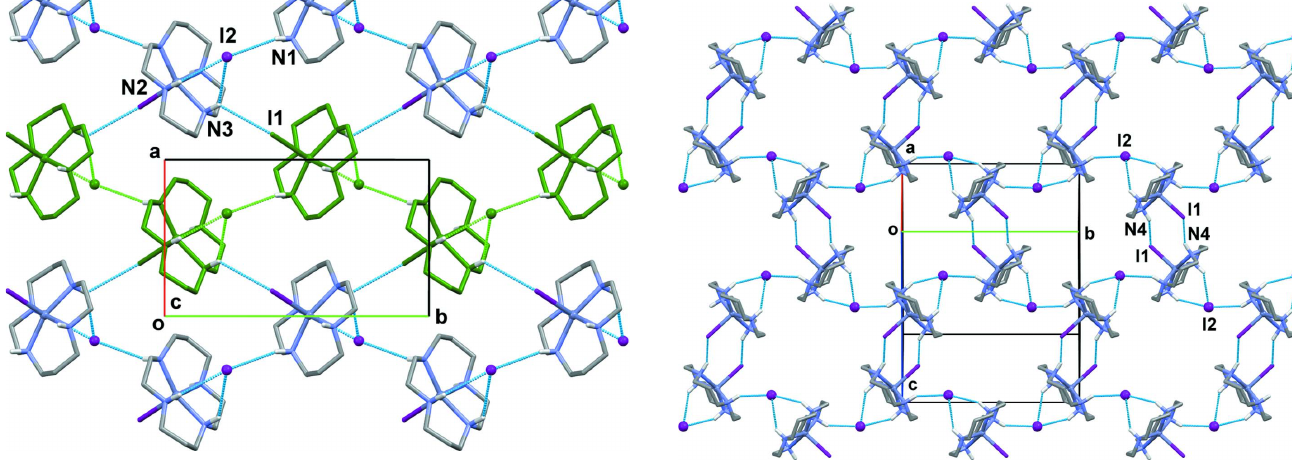
Figure 5 The structure of the hydrogen-bonded layer parallel to the (101) plane in I . Hydrogen-bonding interactions are shown as dashed